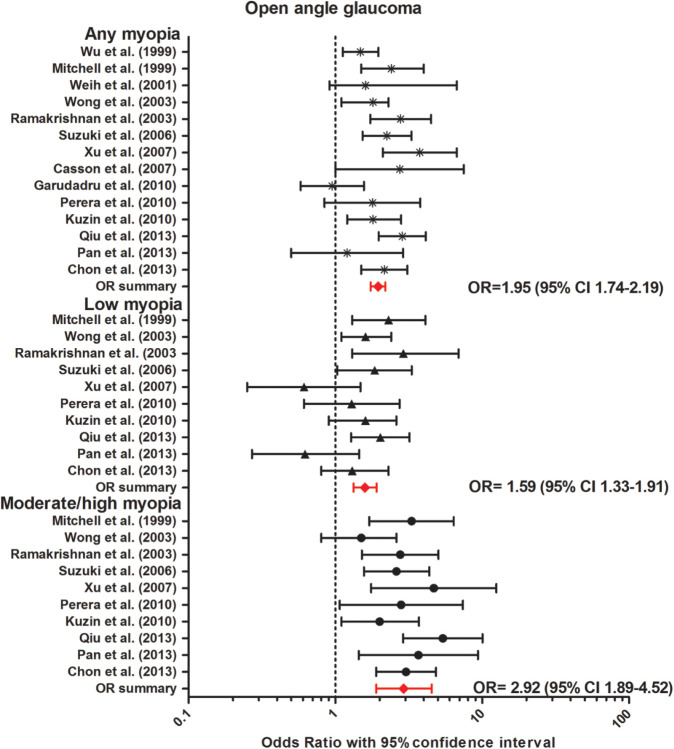
Forest plot of OAG in any myopia (fixed effects model; Q = 8.3; I2 = 0.0); low myopia (fixed effects model; Q = 0.3; I2 = 0.0); and moderate/high myopia (random effects model; Q = 2.6; I2 = 0.0). Red lines with diamond represents the summary OR per myopia category, which are as follows: any myopia OR, 1.95 (95% CI, 1.74–2.19); low myopia OR, 1.59 (95% CI, 1.33–1.91); moderate/high myopia OR, 2.92 (95% CI, 1.89–4.52).